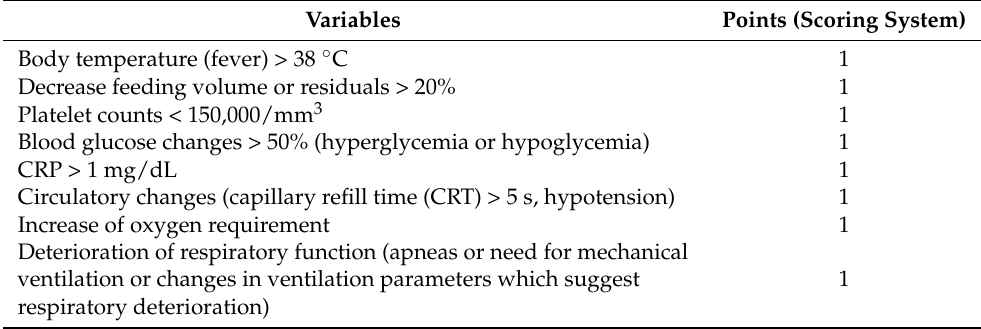
Table 2. Variables of the Sepsis Prediction Score and the scoring system.